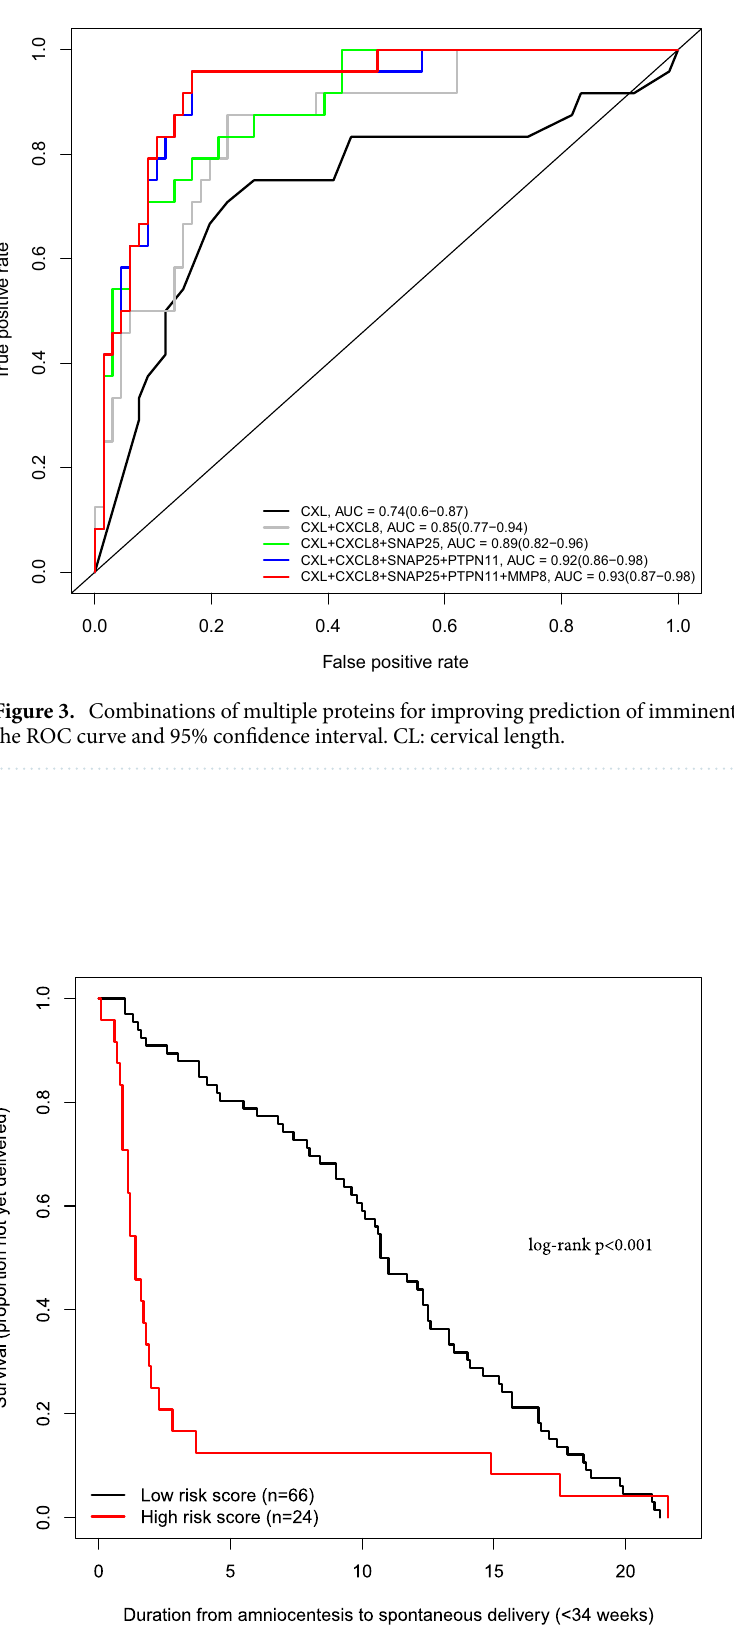
Figure 4. Kaplan–Meier survival curves for patients with a risk score above and those with a risk score below the cut-off value corresponding to a 10% false positive rate. The risk scores are determined by quantitative cervical length and four proteins (CXCL8, SNAP25, PTPN11,